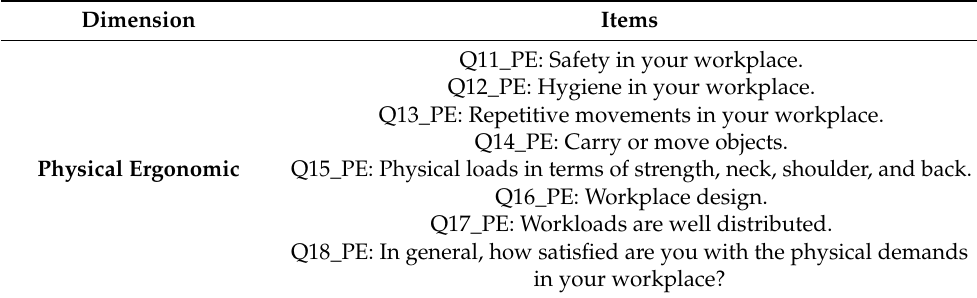
Table 8. Constructs of physical